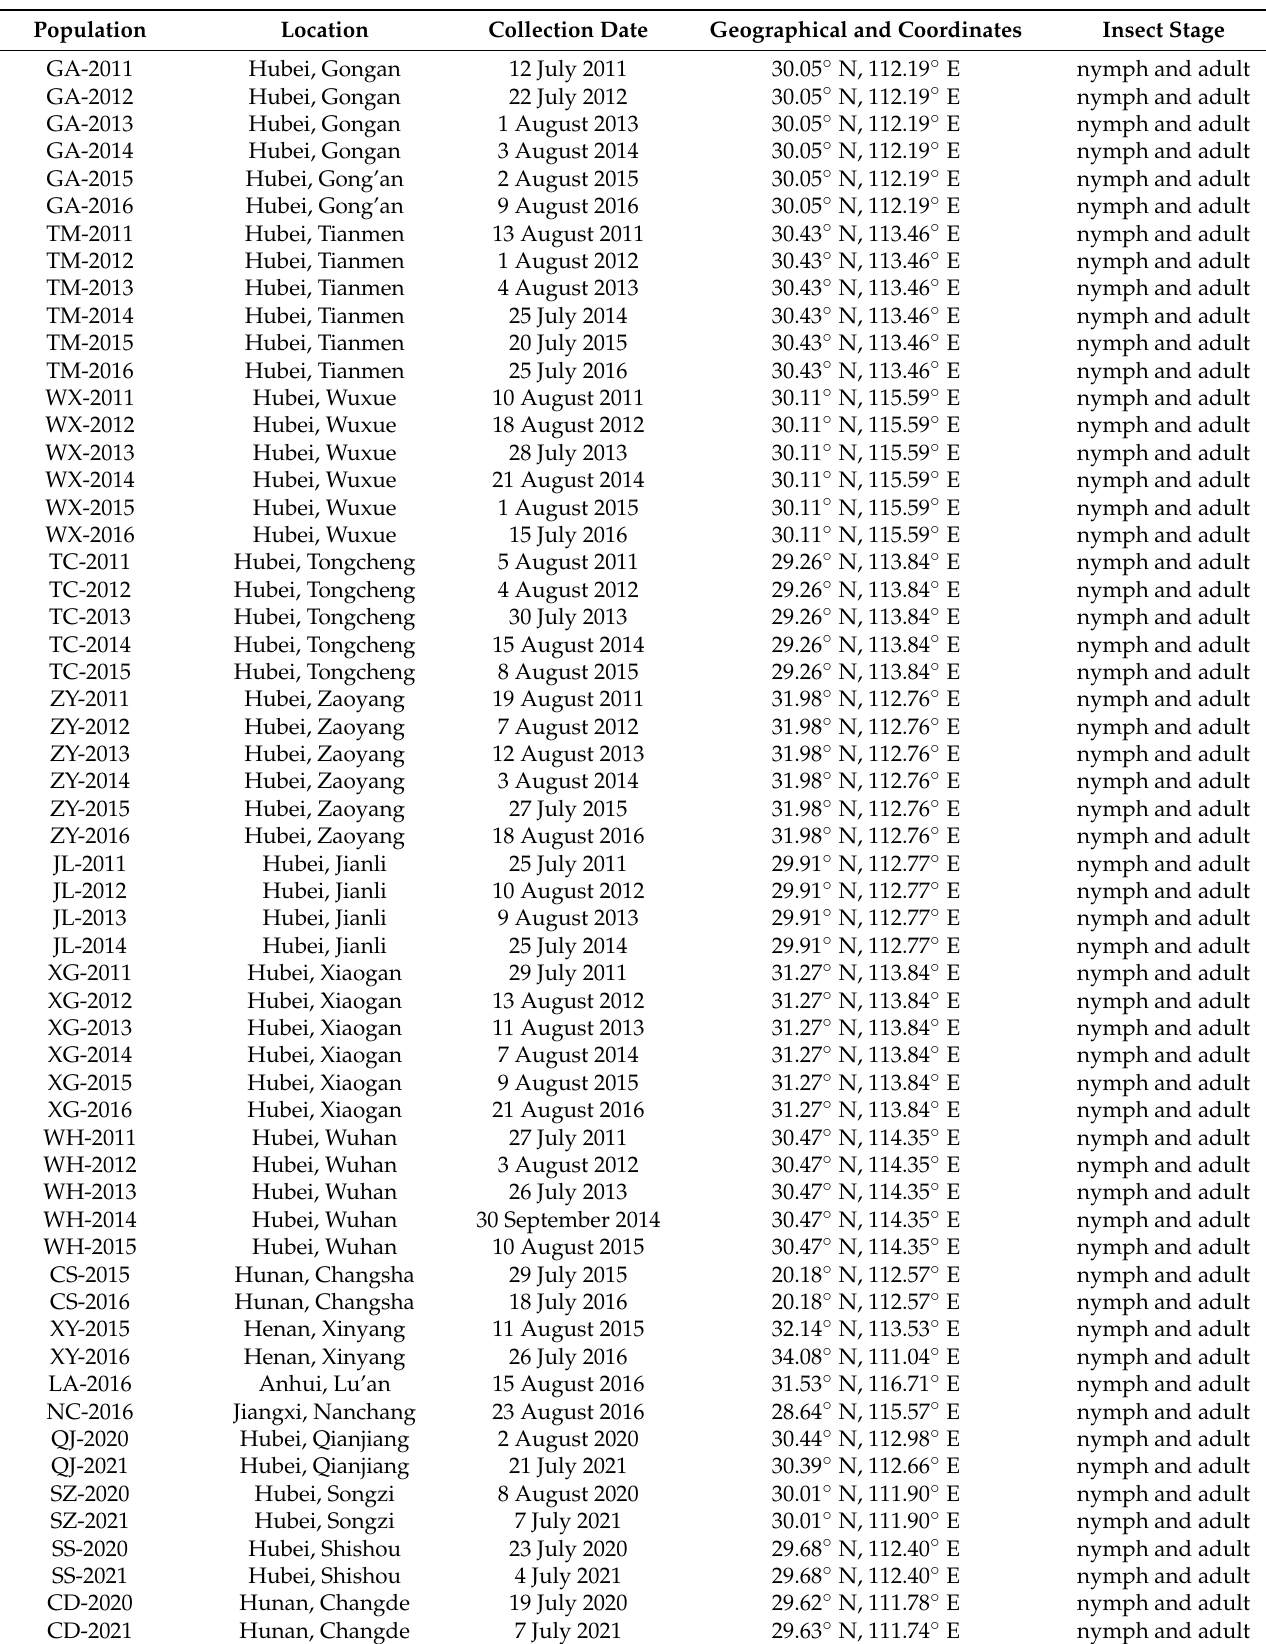
Table 1. Sampling sites, dates and developmental stages of S. furcifera collected from